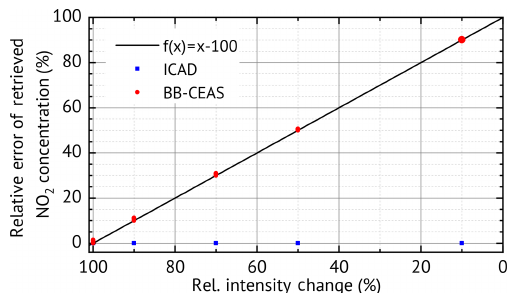
Figure 6. Comparison of the underestimation of the true NO 2 con- centration as a function of relative light source intensity. Values are simulated for our new ICAD method and the BB-CEAS method and exclude effects of photon shot noise.